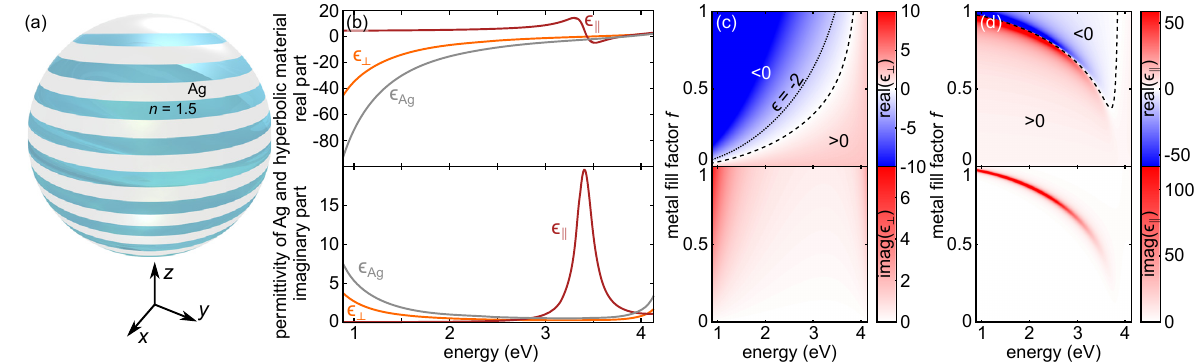
= 1 . 5) and silver layers. In the d 𝜖 ≡ 𝜖 ≡ 𝜖 = 𝜖 ⊥ and perpendicular ∥ permittivities, for which a metal fill factor xx yy zz . The dashed lines mark 0 and split 𝜖 ( ℏ𝜔 , f ) into different dispersion regimes. m m coupling elements between them. In Figure 2a–f we also plot contributions from three active multipoles, namely a strong electric dipole (ED), a weaker electric quadrupole (EQ), and the lone magnetic dipole (MD).